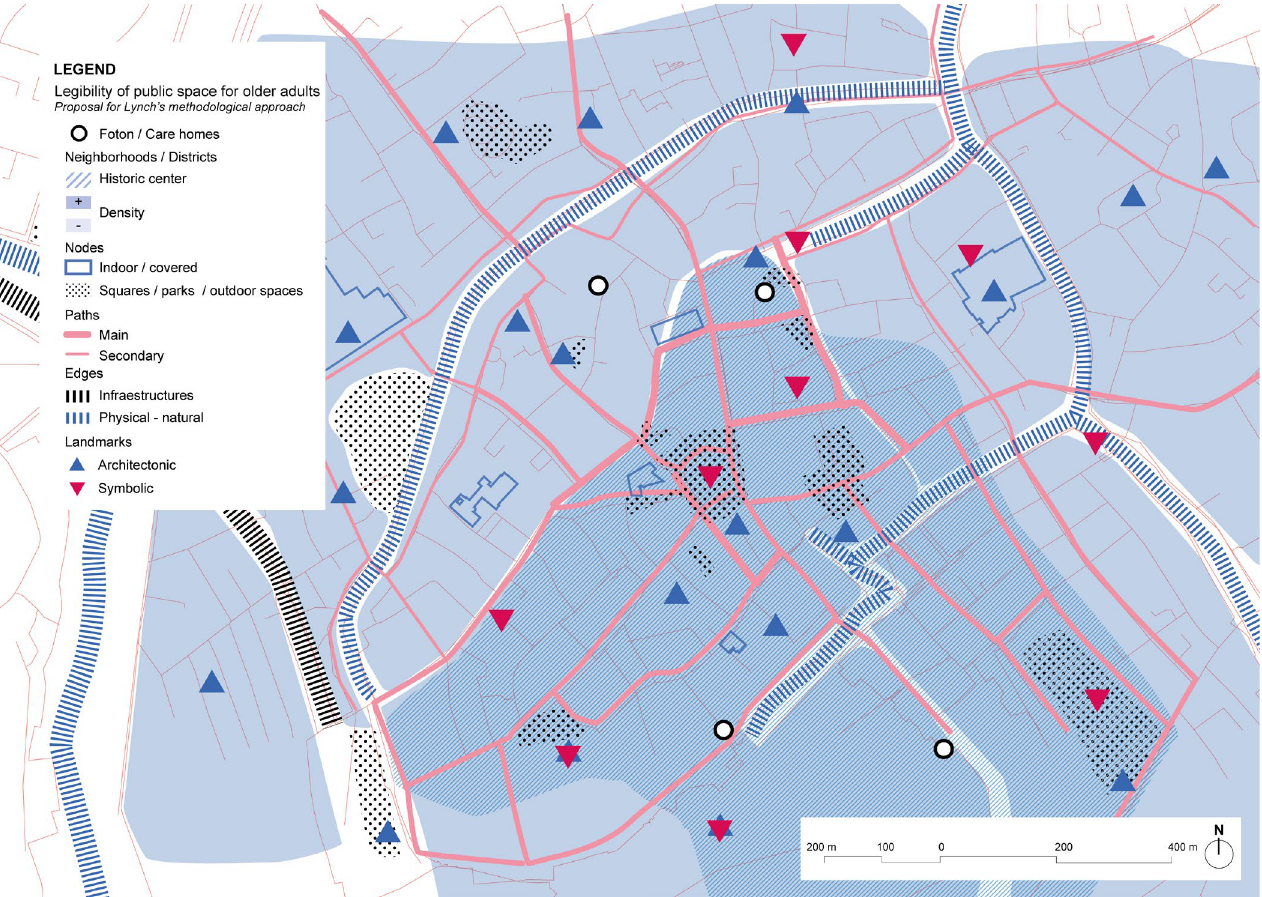
Figure 16. Foton center in the city of Bruges and its surroundings’ scheme based on Lynch’s theory. Source: Own elaboration.